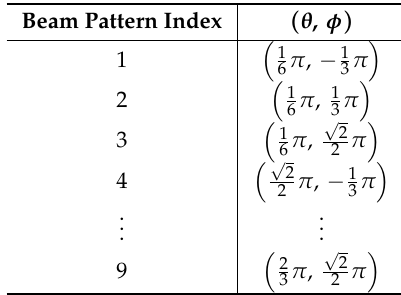
Table 2. Example of the beam